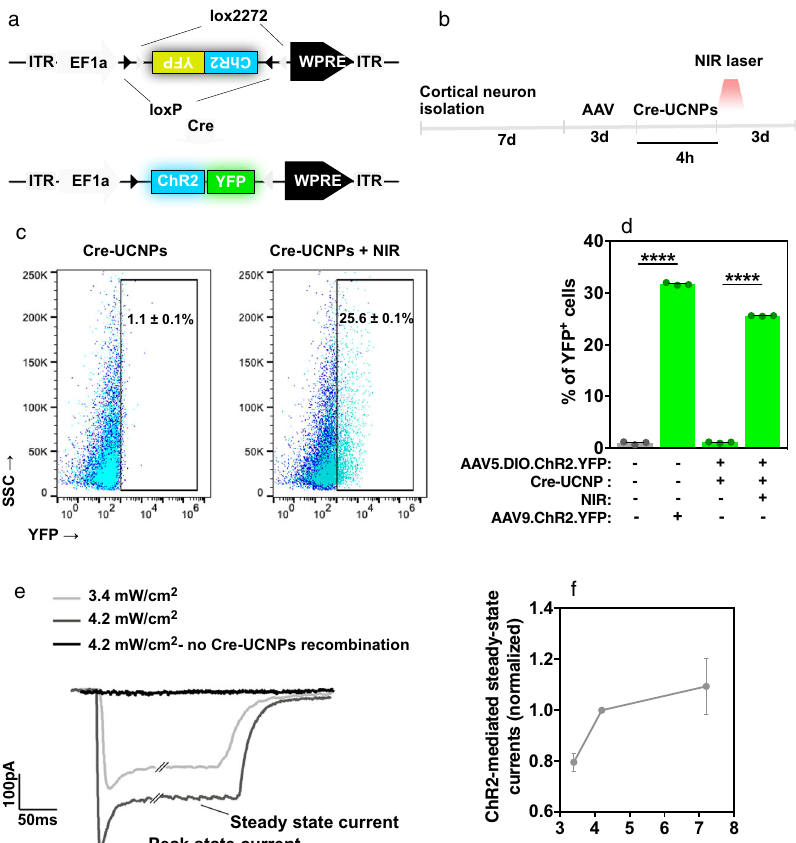
Fig. 5 In vitro gene editing of cortical neurons by Cre-UCNPs followed by cellular activity measurements with optogenetics. a AAV.d fl ox.ChR2-YFP cassette used for Cre-mediated expression of ChR2 in cortical neurons. Cre-UCNPs delivery to cells followed by NIR laser activation leads to the inversion of the double- fl oxed inverted open reading frame and results in the expression of ChR2-YFP fusion protein. b Schematic representation of the experimental setup with cortical neurons. After isolation, cells were cultured for 7 days before treatments. Viral particles (AAV5.d fl ox.ChR2-YFP) were added to the medium for 3 days. Cells were then exposed to Cre-UCNPs (100 µ g/mL) for 4 h, activated by NIR laser (980 nm; 785 mW/cm 2 ; 3 cycles of 5 min irradiation) and allowed to recombine for 3 days. Neurons were activated by a blue light for electrophysiology measurements. c Flow cytometry analyses of ChR2-YFP expression in neuronal cultures. Cells were transfected with Cre-UCNPs and activated or not with a NIR laser. Positive cells were gated based in the basal expression of ChR2-YFP in nontreated cortical neurons (dark blue). d Quanti fi cation of recombination by fl ow cytometry. Results are Mean ± SEM ( n = 3). Statistical analyses were performed by one-way ANOVA followed by Bonferroni ’ s multiple comparisons test: (****), P < 0.0001. e Representative traces of ChR2-mediated currents, showing dependency on the intensity of blue light. Scale bars = 100 pA, 50 ms. Darker trace shows the dependence of Cre-UCNP recombination on the generation of photocurrents. f Voltage-clamp currents generated from different blue-light stimulus. Results are Mean ± SEM ( n = 3 independent